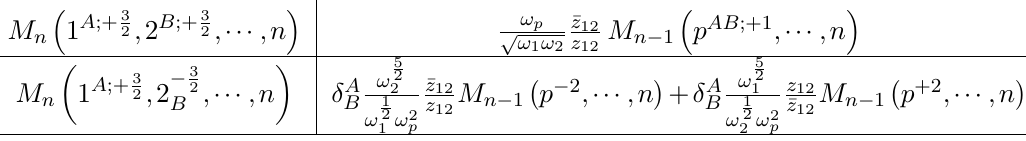
Table 5 . Amplitude corresponding to two collinear gravitinos.